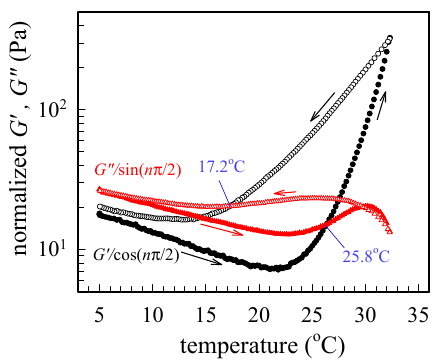
Figure 4. Hysteresis curves of normalized G (cid:48) and G (cid:48)(cid:48) of the 12 wt% solution upon 0.2 ◦ C/min heating to 32 ◦ C, followed by a subsequent 0.2 ◦ C/min cooling. The filled and open symbols are data obtained during heating and cooling, respectively. The critical relaxation exponent ( n ) is